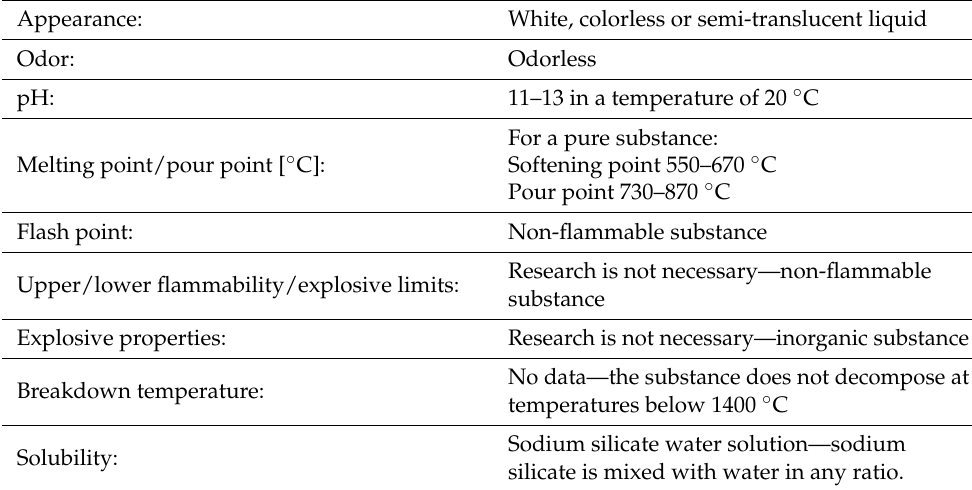
Figure 3. Properties of the Cement CEM I 42.5 R: ( a ) particle size distribution; ( b ) chemical composi- tion (based on the data provided in [30]). Table 3. The chemical and physical properties of the sodium silicate (own study based on the data provided in